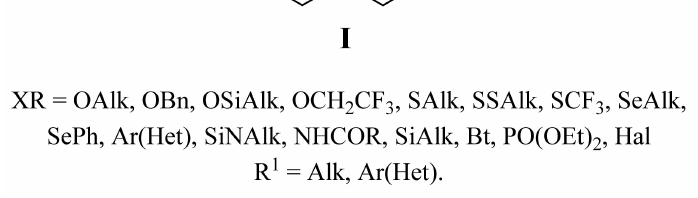
Figure 1. α -Functionalized